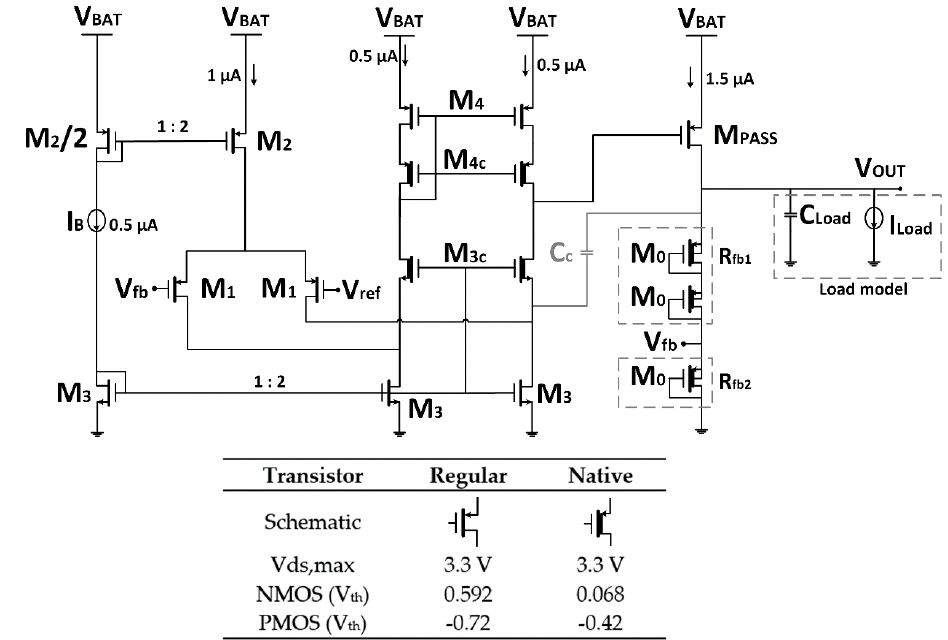
Figure 3. Core structure of the proposed CMOS LDO regulator for a 1.2 V output.